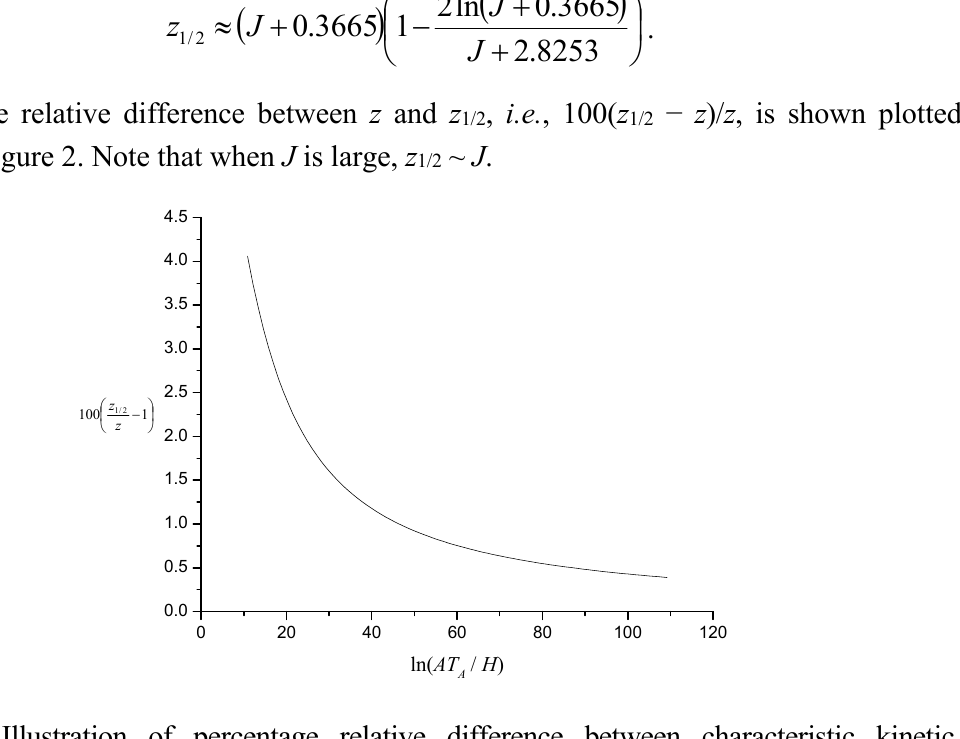
Figure 2. Illustration of percentage relative difference between characteristic kinetic temperature and temperature at